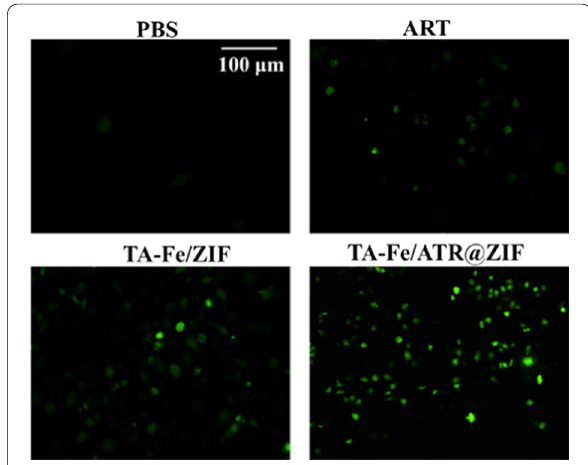
Fig. 5 ROS production detected by fluorescence of DCFH-DA in MDA-MB-231 cells treated with ART, TA-Fe/ZIF, and TA-Fe/ART@ZIF